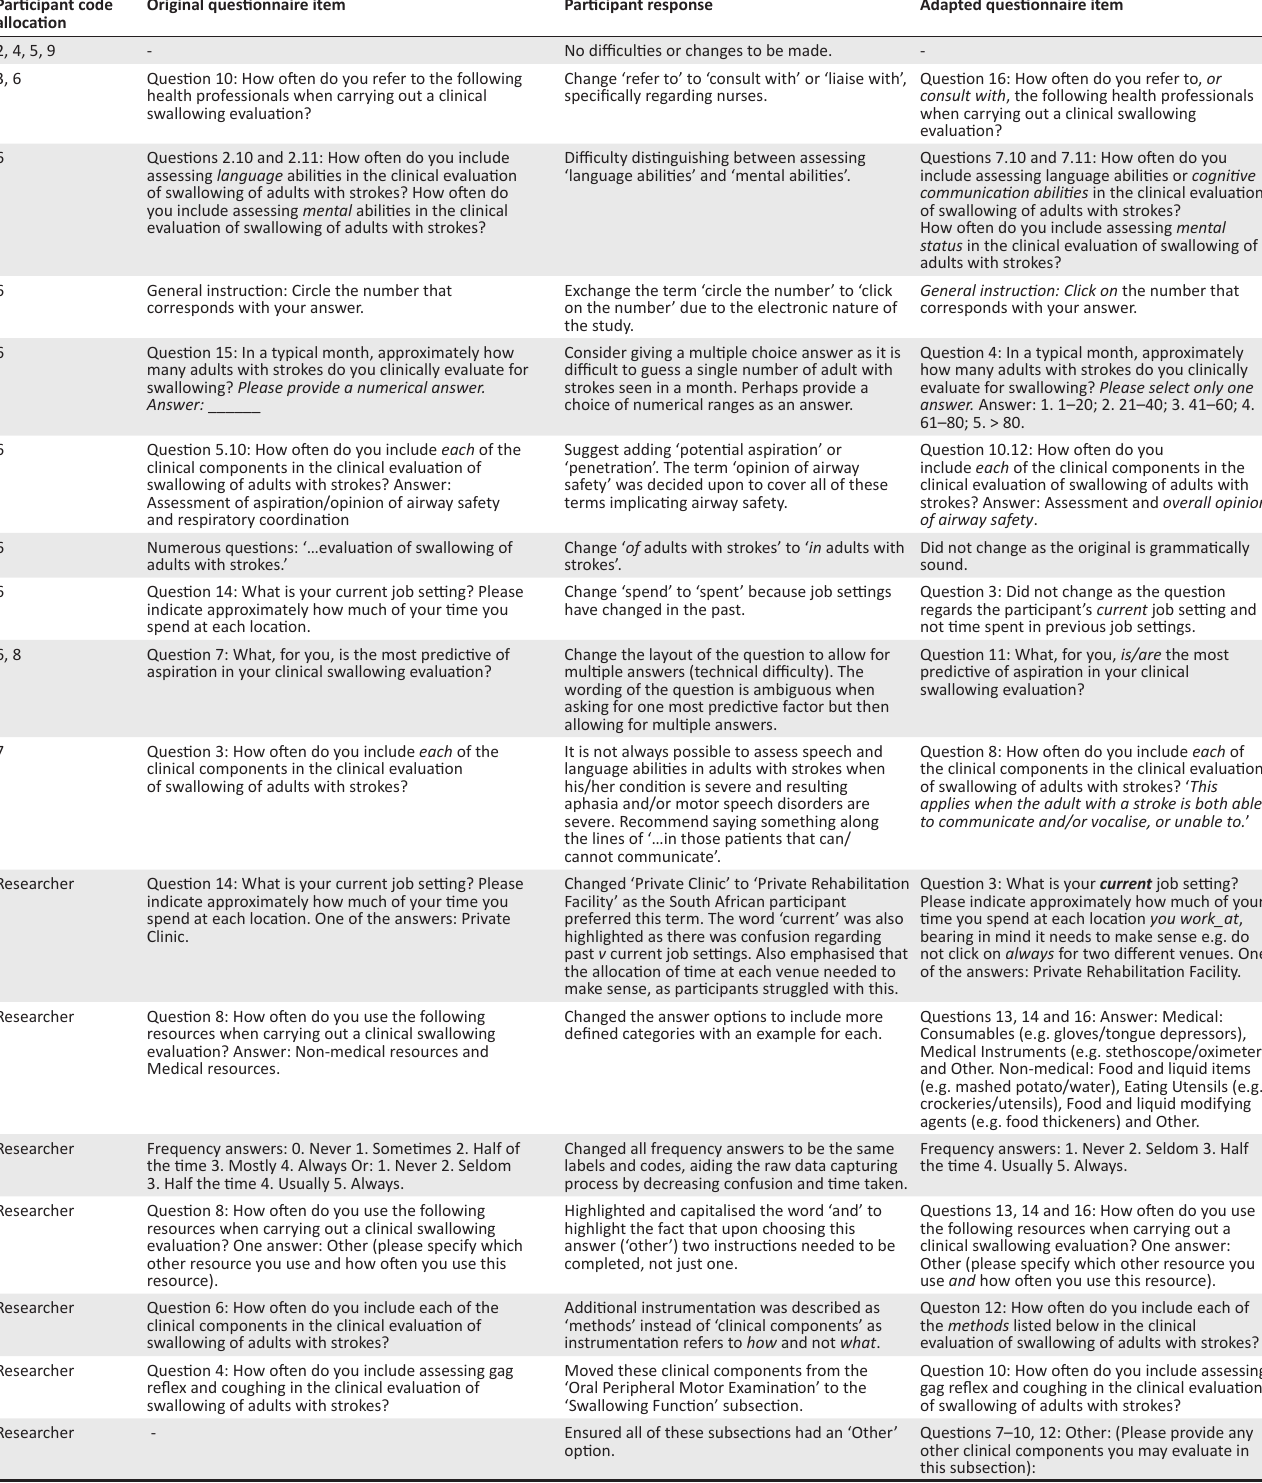
TABLE 1: Description and rationale for the pilot study adaptations to the